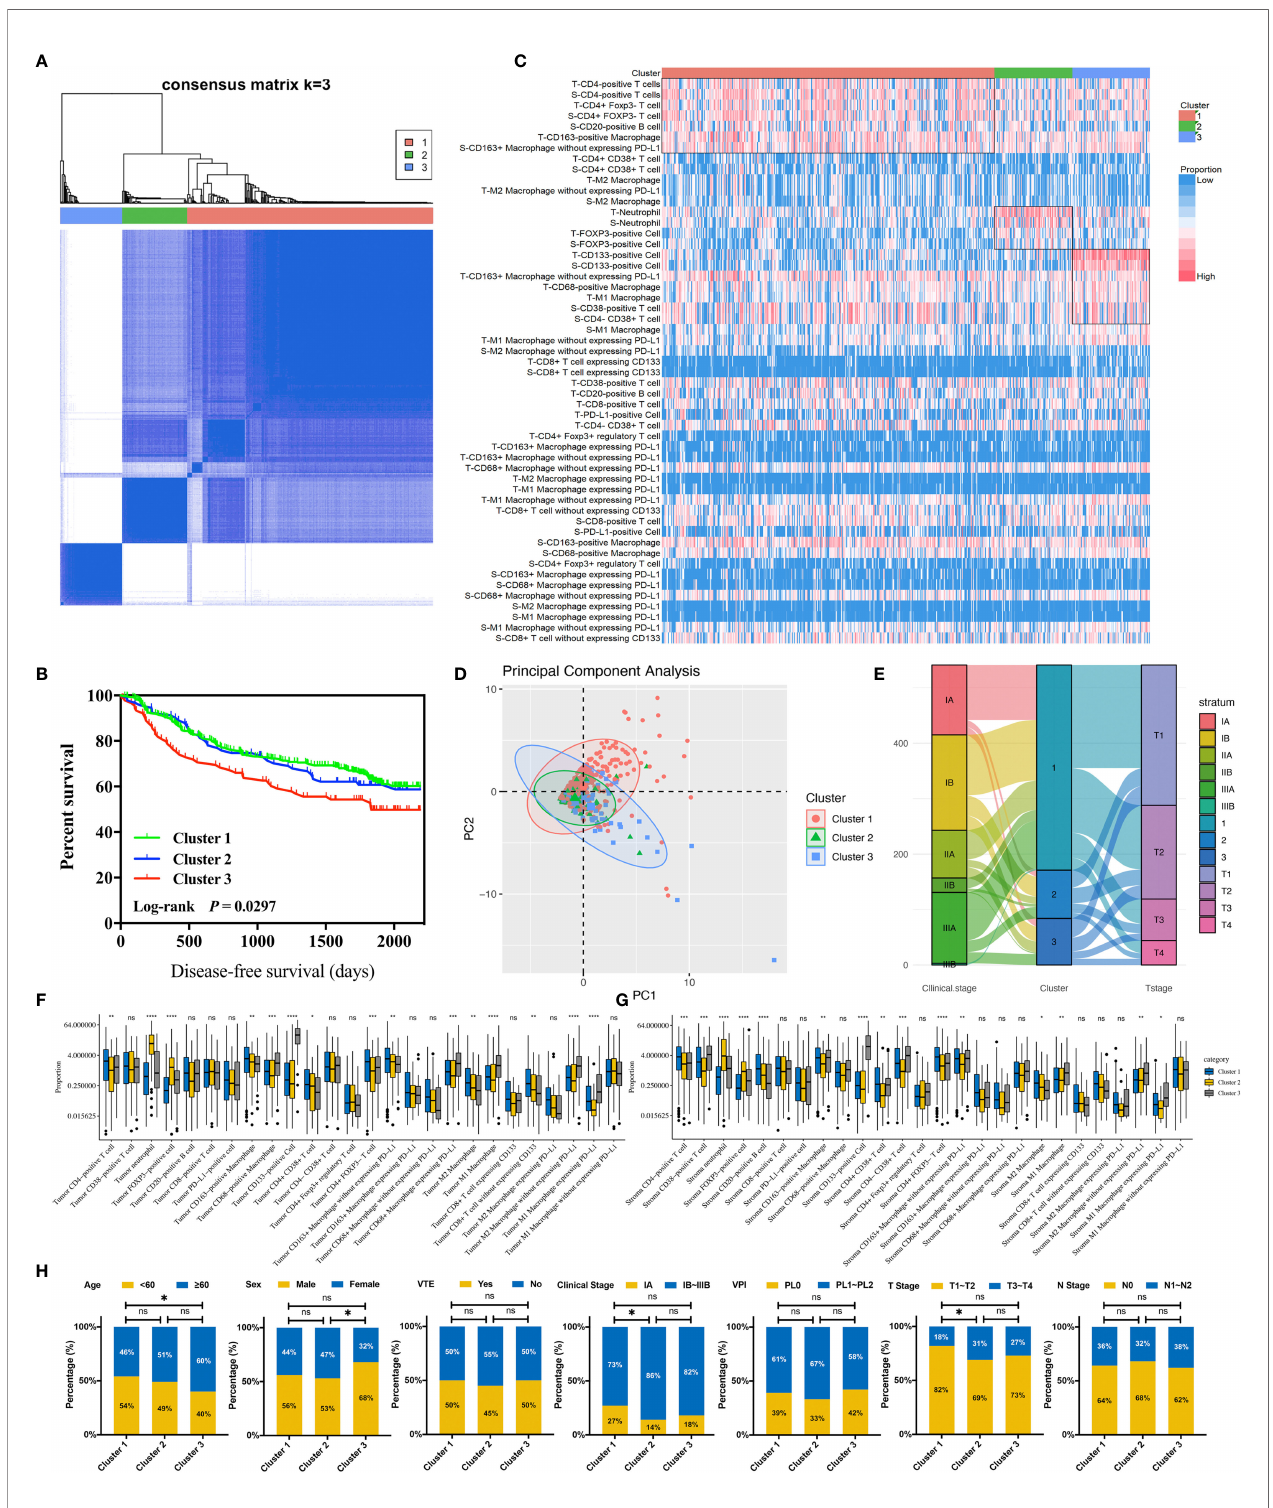
FIGURE 3 | Identi fi cation and analysis of three immune clusters of 681 non-small cell lung cancer cases. (A) Consensus clustering matrix for k = 3. (B) Kaplan – Meier curve demonstrates the disease-free survival differences among three clusters. (C) The immune landscape of three clusters illustrates distinct cellular characteristics. (D) Principal component analysis of three clusters. (E) Sankey plot indicates the clinical characteristics differences among three clusters. (F) In fi ltration disparities of three clusters in the tumor nest. (G) In fi ltration disparities of three clusters in the tumor stroma. (H) Chi-square test reveals the disparities of the clinical characteristics of the patients among three clusters. * P < 0.05; ** P < 0.01; *** P < 0.001; **** P < 0.0001; ns, nonsigni fi cant; VTE, vascular tumor emboli; VPI, visceral pleural